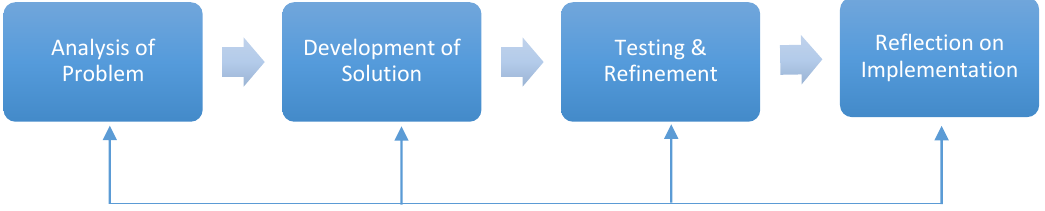
Figure 2. Design-Based Research using Reeves (2006) [52] model.